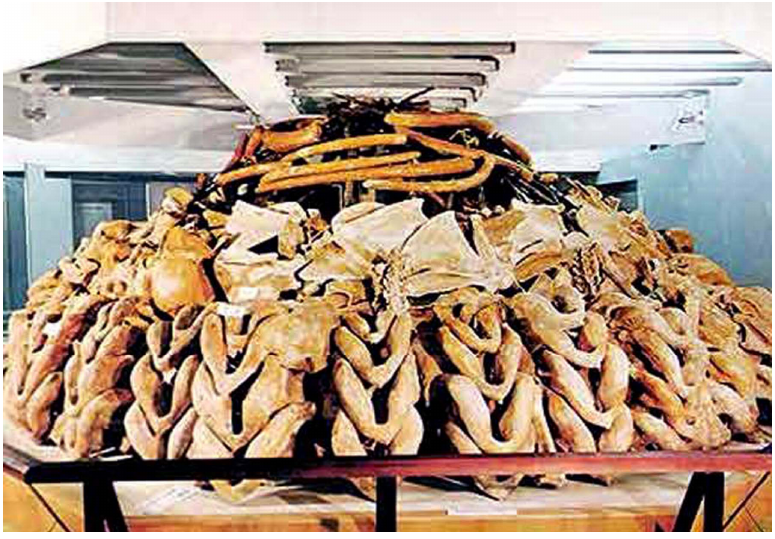
Figure 6. Mezhyrich Dwelling 1 Reconstruction [32]. Photo: courtesy National Museum of Natural History, Kiev.